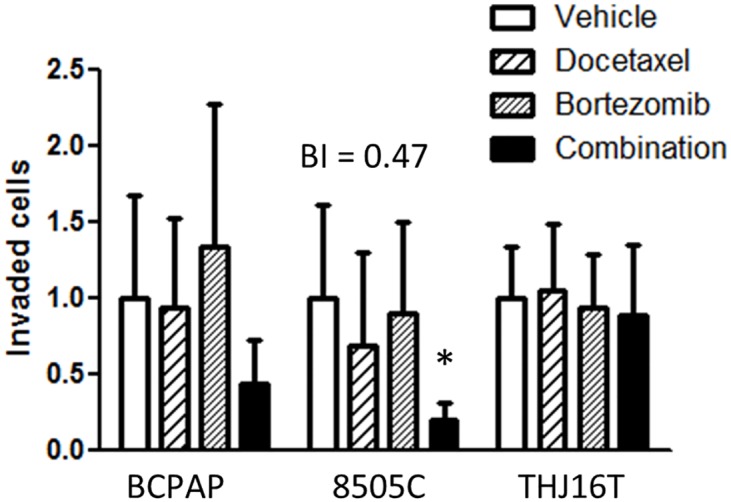
The docetaxel and bortezomib synergistically decrease thyroid cancer cell line 8505C invasion in vitro.Asterisks indicate a significant effect of the drug combination (p<0.05, repeated measurements one-way ANOVA, Newman-Keuls posttest). The effect of the drugs on the invasion of BCPAP and THJ16T cells was not significant. BI—Bliss independence index.